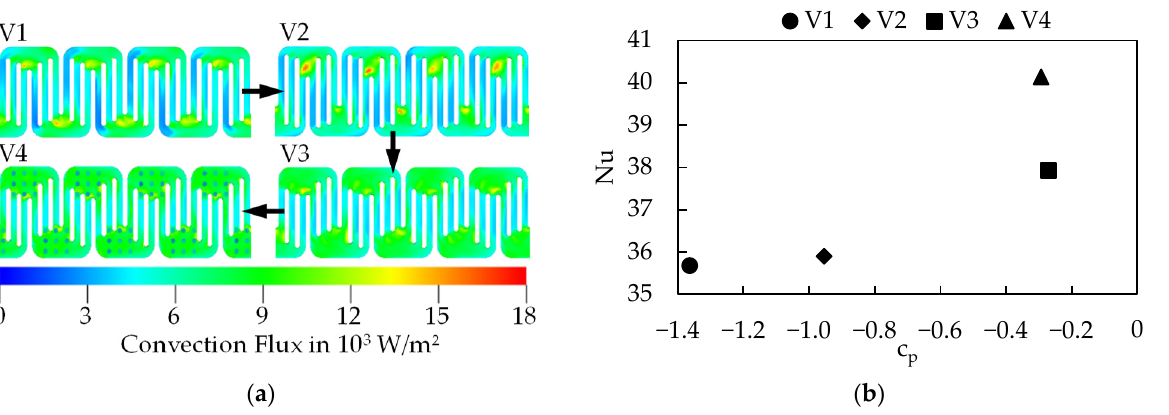
Figure 9. Final optimization of cooling plate versions: ( a ) convection flux in excerpts of the cooling plate channels; ( b ) Nusselt number over pressure coefficient. Based on [39].